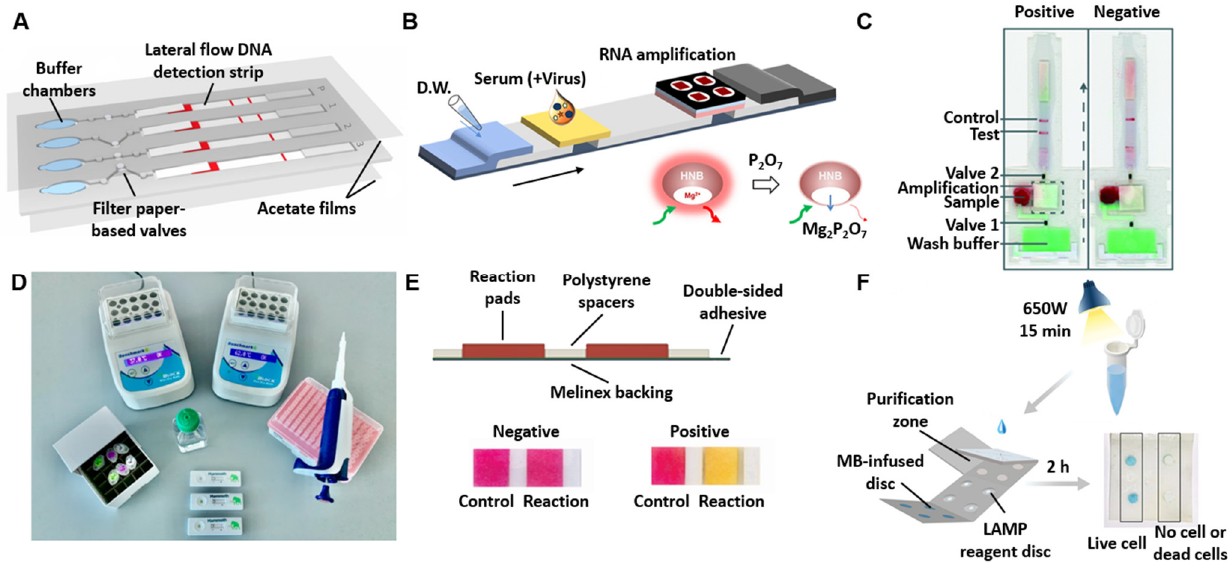
Figure 5. Summary of recent paper-based biosensors. ( A ) Paper-based microfluidic device that enables multiplex loop-mediated isothermal amplification (LAMP)-based detection of malaria in blood. Following the LAMP reactions in the buffer chamber, the test samples were then transferred to the lateral flow strip by pressing manually on the buffer chambers. This device can run up to three LAMP reactions at a time with a positive control to account for environmental factors and